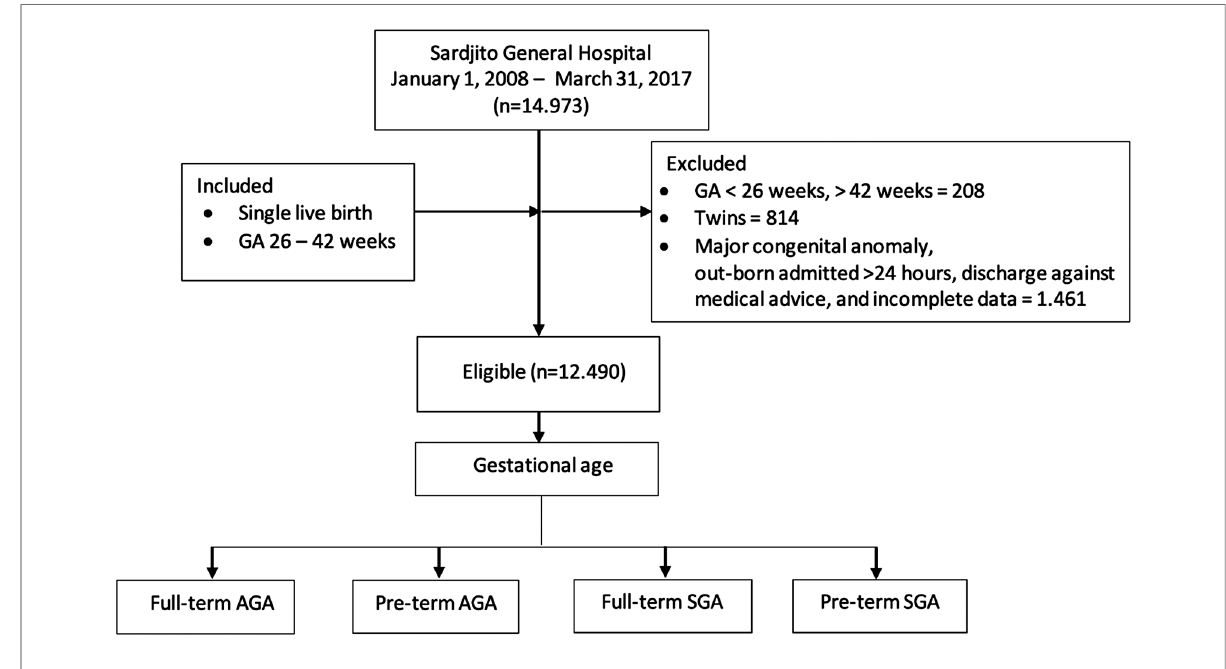
FIGURE 1 Flowchart of the